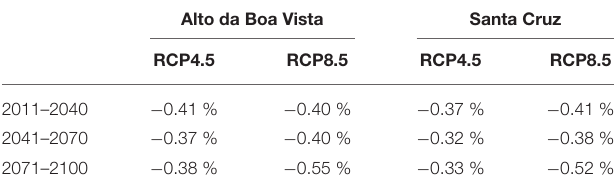
TABLE 4 | Temperature projections for the Alto da Boa Vista and Santa Cruz meteorological stations, over the 21st century, based on the Eta-HadGEM2-ES method.